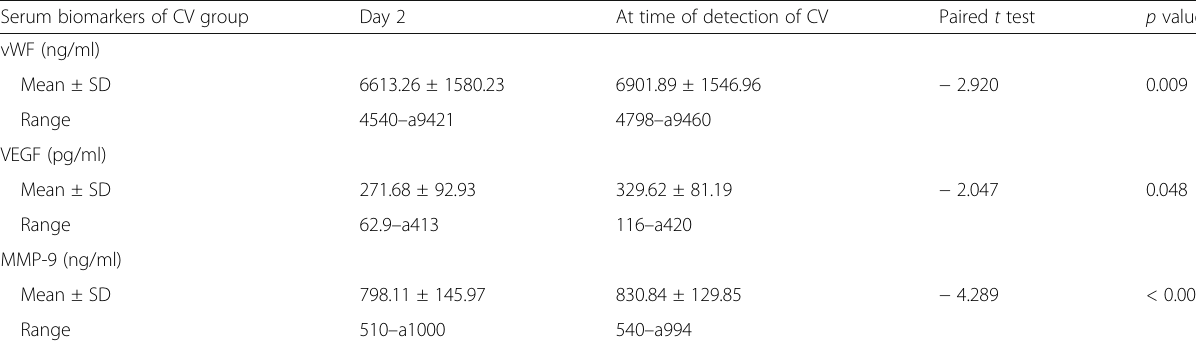
Table 3 Comparison between serum biomarker concentrations on day 2 of aSAH and at time of CV Serum biomarkers of CV group Day 2 At time of detection of CV Paired t